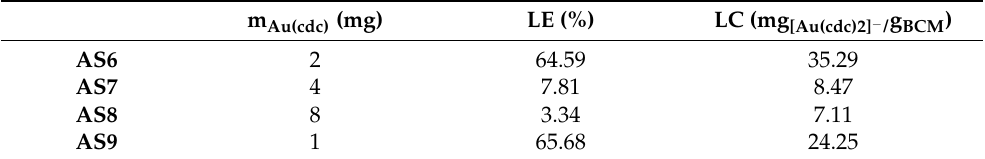
Table 3. Loading efficiencies (LEs) and loading contents (LCs) for the indicated amounts of gold complexes (m cdc